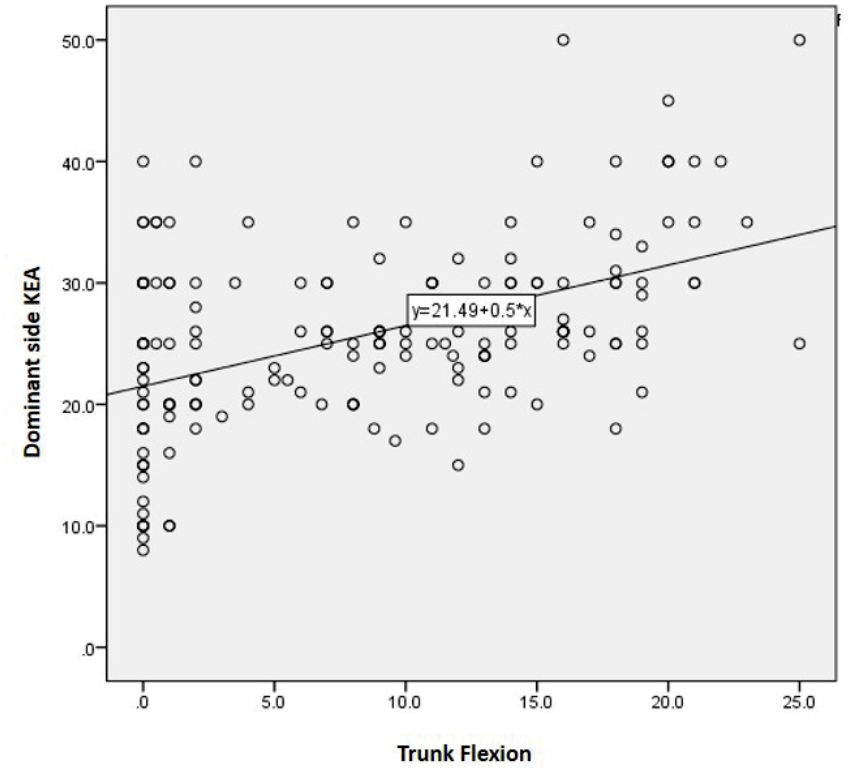
Figure 2: Correlation between hamstring muscle tightness and trunk flexion during forward bending